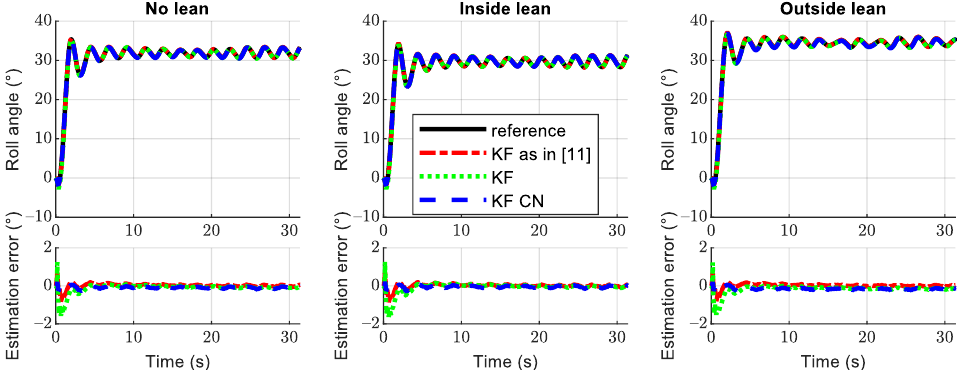
Figure 9. Estimated roll angle and roll angle error for the Circular test track . The left plot represents the maneuver with the rider in a neutral position, the central plot represents the rider tilting inwards during the turn, and the right plot represents the rider tilting outwards during the